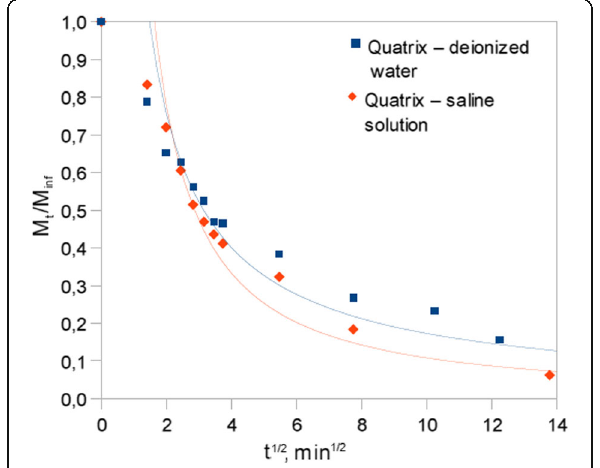
Fig. 1 Dehydration curves obtained as changes in mass